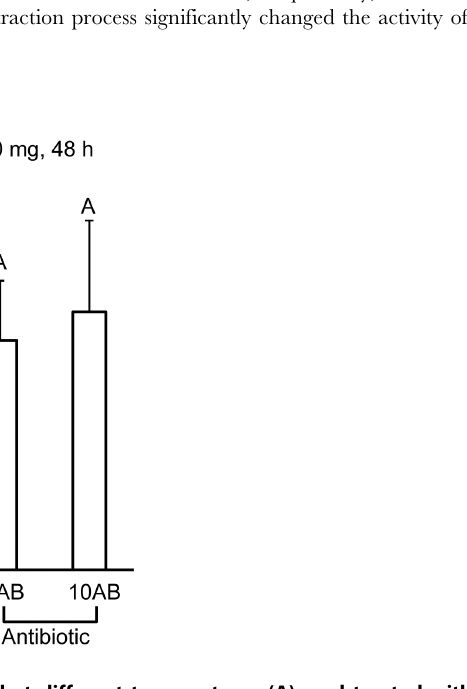
Figure 4. Percentages of post larvae on C.gigas SC that were heated at different temperatures (A), and treated with antibiotic solutions (B). A: Boxes with slanting lines and shading indicate results of heat treatment experiments of 50 mg SC and 500 mg SC, respectively. x indicates no data. B: blank boxes indicate the antibiotic treatment experiment of 50 mg SC. 1AB=streptomycin sulphate 20 mg L 2 1 , penicillin G 10 mg L 2 1 , neomycin 2 mg L 2 1 , and kanamycin 10 mg L 2 1 , and 10AB=1AB concentration increased tenfold. Data are means of 6 to 9 replicates and error bars represent standard deviations (SD). Lowercase and uppercase letters indicate results of the post hoc Tukey HSD test on heat and antibiotic treatments, respectively. Groups connected by the same letter are not significantly different (p $ 0.05).